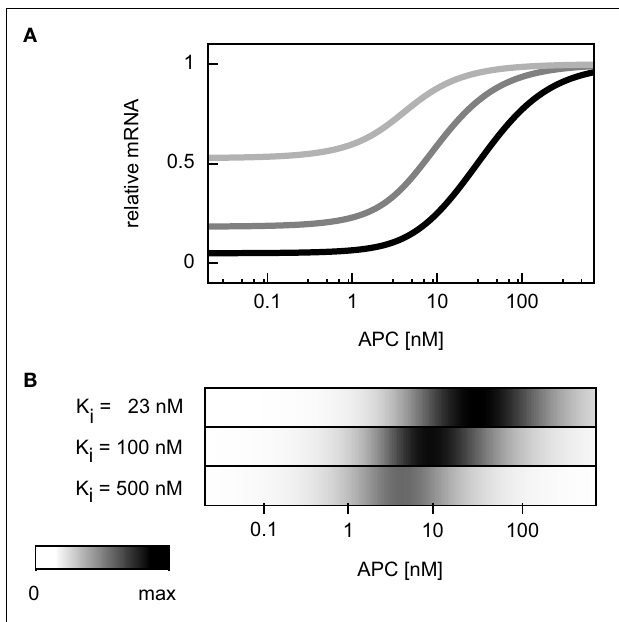
FIGURE 7 | Dependence of the criticalAPC concentration for target gene induction on the inhibition constant. (A) The steady state concentration of target gene mRNA is compared assuming different values of the inhibition constant K i : 23, 100, and 500nM (black, dark gray, and light gray, respectively). For each curve, the steady state is normalized to the respective maximal mRNA concentration. (B) The absolute values of the concentration changes along the curves of (A) are plotted.The maximal calculated change is color-coded in